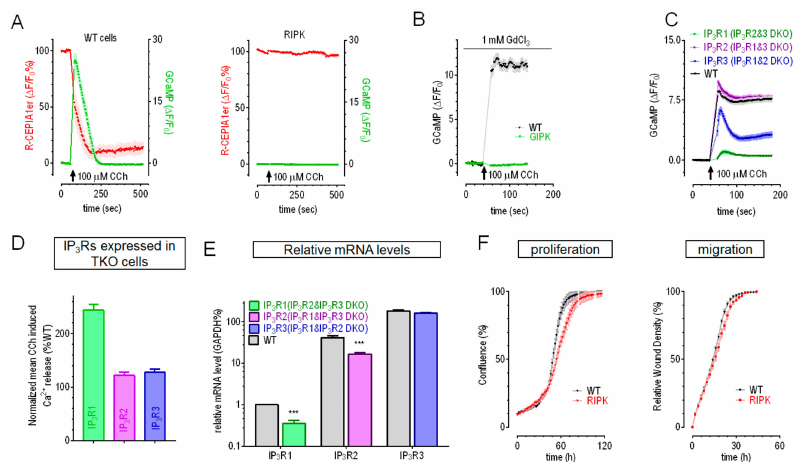
Figure 1. Characterization of HEK IP 3 Rs-TKO and IP 3 Rs-DKO cells. ( A – C ) Typical carbachol (CCh, 100 µ M)-induced Ca 2 + responses from ER in HEK IP 3 Rs-TKO and IP 3 Rs-DKO cells. ( A ) CCh-induced Ca 2 + changes as shown with transiently expressed cytoplasmic Ca 2 + indicator GCaMP6m (Green) or stably expressed ER Ca 2 + indicator R-CEPIA1er (Red). Left panel, responses of WT HEK cell stabling expressing R-CEPIA1er; right panel, R-CEPIA1er stable cells with IP 3 Rs-TKO (RIPK). ( B ) Representative CCh-induced responses in HEK GCaMP6m stable cells without (WT, black trace) or with IP 3 Rs-TKO (GIPK, green trace). ( C ) Typical CCh-induced Ca 2 + releases in HEK GCaMP6m WT cells or those with IP 3 Rs-DKO. 1 mM GdCl 3 was included in bath solution to block Ca 2 + movements across PM in (B,C) (n = 3). ( D ) Statistics showing relative sizes of mean CCh-induced Ca 2 + releases in RIPK or GIPK cells transiently expressing IP 3 Rs (see Figure S1A,B for typical curves). ( E ) Relative mRNA levels of three types of IP 3 Rs in HEK cells and IP 3 Rs-DKO. mRNA levels were first normalized against corresponding GAPDH levels, then normalized against corresponding IP 3 R1 levels of WT cells. Expression levels of IP 3 R1 in WT cells were set as 1 (mean ± SEM, *** P < 0.0001, Student’s t -test). ( F ) Typical proliferation (left panel) and migration (right panel) curves of RIPK and WT